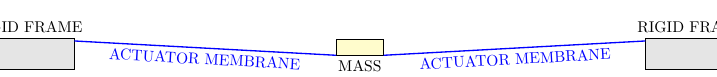
Figure 5. Diagram of DEAP actuator with power off.